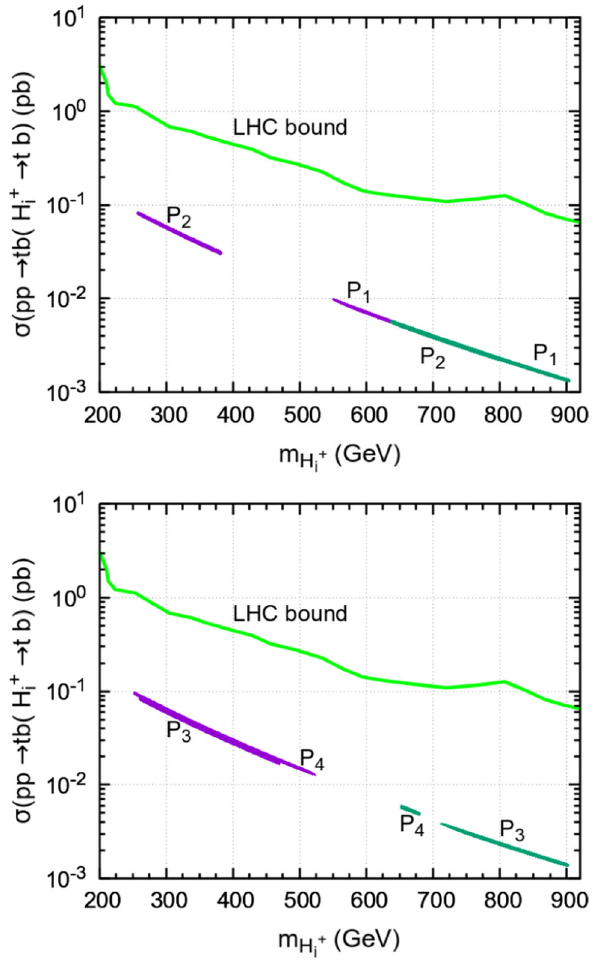
→ tb ) versus the charged Higgs Fig. 14 σ( pp → tbH + ) × BR ( H + i mass for benchmark points P 1 and P 2 (upper panel) and P 3 and P 4 (lower panel). In magenta we have H + and in dark green we consider 1 → tb ) = 1. The light green line is the current H + . We took BR( H + i 2 LHC